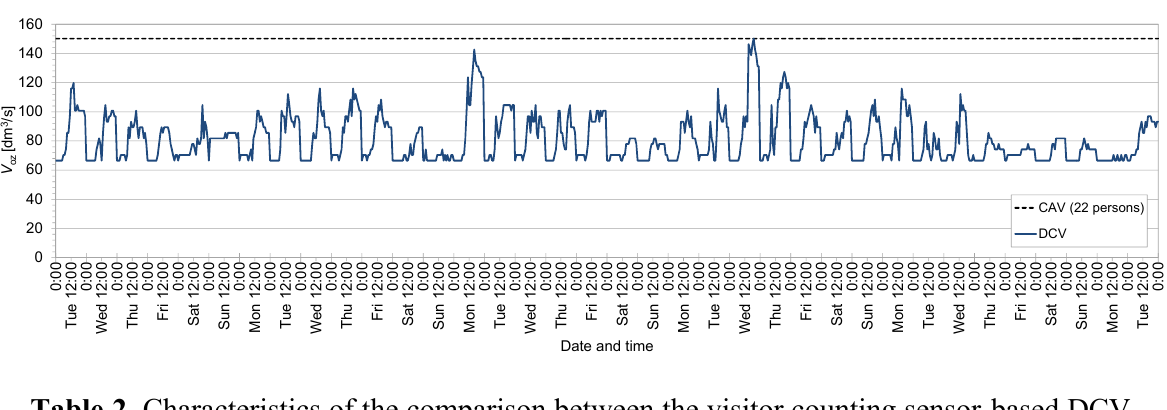
) of the Café room using the visitor oz